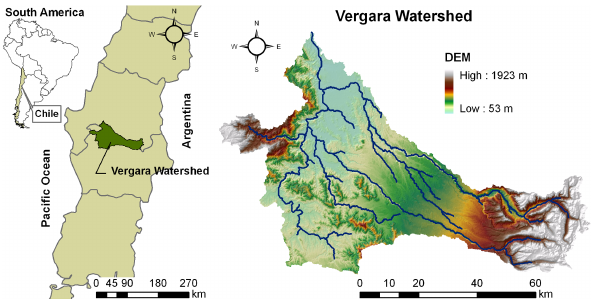
Fig. 1. Location of the Vergara watershed and DEM.